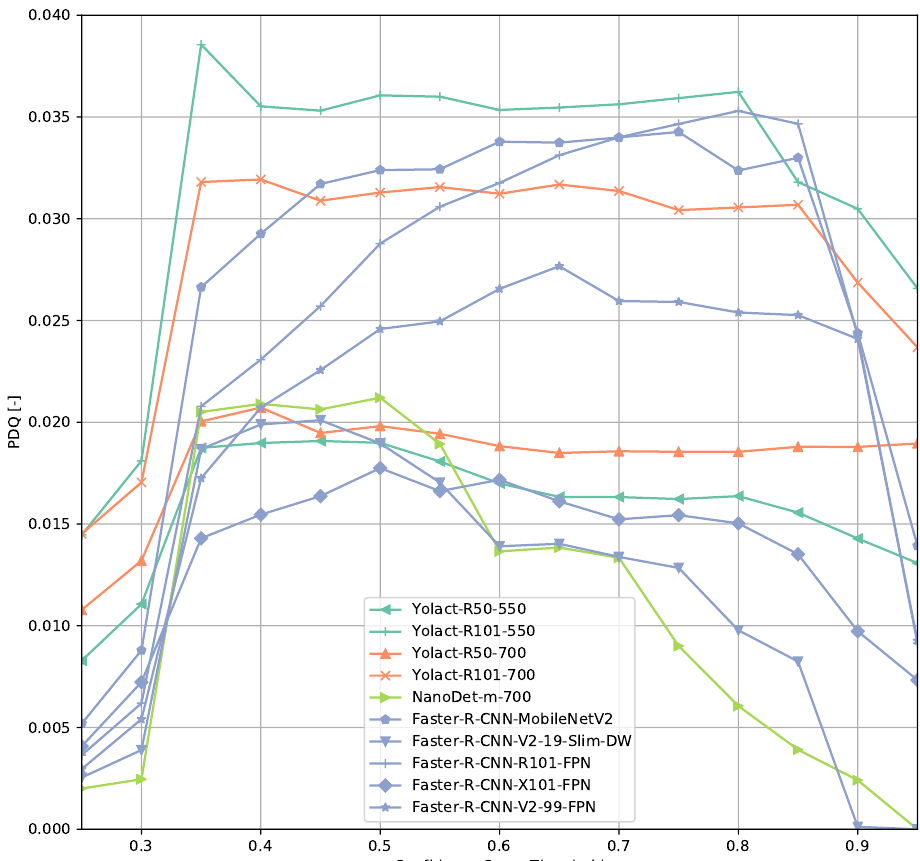
Figure 16. PDQ results on TTPLA (power lines excluded from